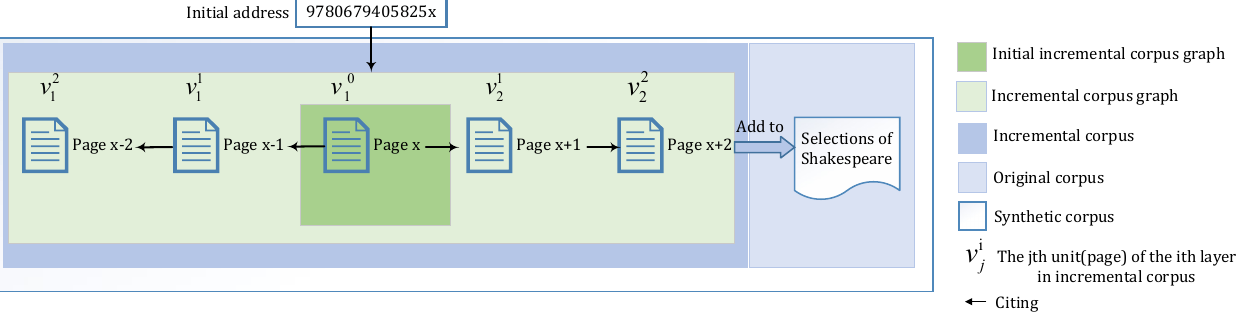
Figure 2. An example of using ISBN address to construct the synthetic corpus. In the example, V ι = v 0 and E ι = ∅ 1